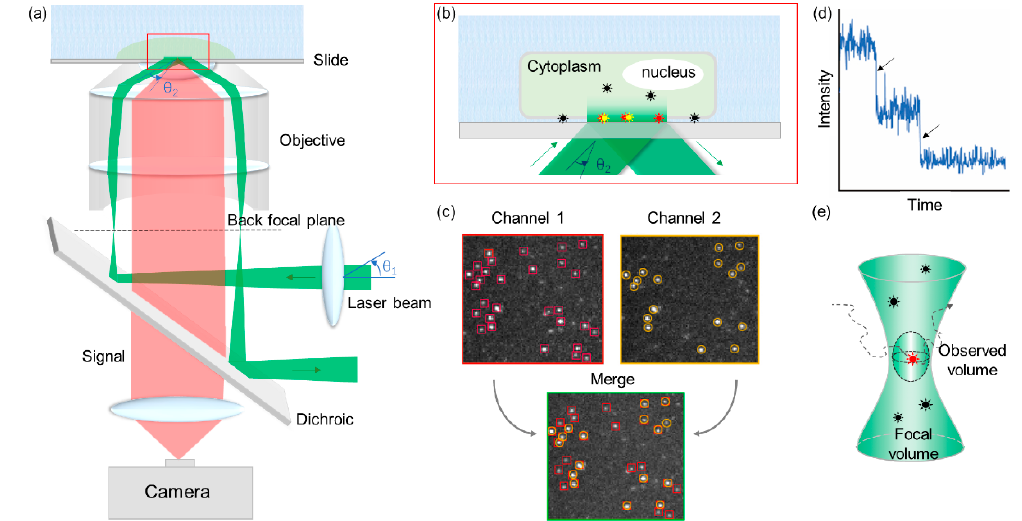
Figure 3. ( a ) Schematic of the total internal reflection fluorescence microscopy (TIRFM) and variable- angle (VA)-TIRFM layout. A focused laser beam (green) is reflected at the back of the objective focal plane, passed through the objective lens, and totally internally reflected. The signal (red) passes through the dichroic and is captured on a camera. By changing the angle of the laser beam ( θ 1 ), the incident angle ( θ 2 ) is variable and converts TIRFM to VA-TIRFM. ( b ) Enlarged view of the total reflection area in the sample and slide surface. Fluorophores within the evanescent filed field (approximately 100 nm) were excited (red and yellow). ( c ) Schematic representation of CoSMoS. If fluorophore-s labeled target proteins associate with each other, positions of spots in each channel (red box in channel 1 and yellow circle in channel 2) can be overlaid in the merged image. ( d ) An example of the double-step bleaching event trajectory. ( e ) Schematic representation of fluorescence correlation spectroscopy/fluorescence cross-correlation spectroscopy (FCS/FCCS) and photon counting histogram (PCH). The diffusion of fluorophore-labeled molecules in and out of the observed volume induces fluctuations in fluorescence with time. Their diffusion parameters and number of particles can be obtained by fitting the fluorescence fluctuation curve to an adequate diffusion model. 3.2.2. FRET FRET is a popular tool to measure the dynamic activities of biological molecules at the nanoscale [76,77]. In FRET, a donor fluorophore absorbs a photon and nonradiatively transfers this energy to an acceptor fluorophore when the distance separating them is less than 10 nm. The efficiency of FRET varies in proportion to the inverse sixth power of the distance between the donor and acceptor molecules. Therefore, measuring the FRET efficiency can enable the calculation of the precise donor– acceptor distance, which reflect labeled protein–protein or protein–ligand distances, at the angstrom level. By real-time tracking of nanoscale conformational changes, protein–protein interaction events, or ligand binding events at the single-molecule level, the molecular mechanism of macromolecules can be revealed [78]. Recently, single-molecule FRET has been widely used to study conformational changes of biological molecules and intermolecular interactions. However, only a few works have used FRET in plant systems. Compared with BiFC, which only uses one fluorophore color, the background fluorescence from chloroplast precludes the selection of proper FRET donor–acceptor pairs whose spectra must be separated from the background simultaneously [79]. This challenge has been overcome by combining single-molecule FRET with fluorescence lifetime imaging microscopy [80], where the contrast is based on the lifetime of individual fluorophores rather than their emission spectra. This has led to the exploration of numerous interactions (e.g., BRI1–SERK3/BAK1 and BRI1– P-ATPase interactions) with bulk, but not single-molecule, FRET measurements [81–83].